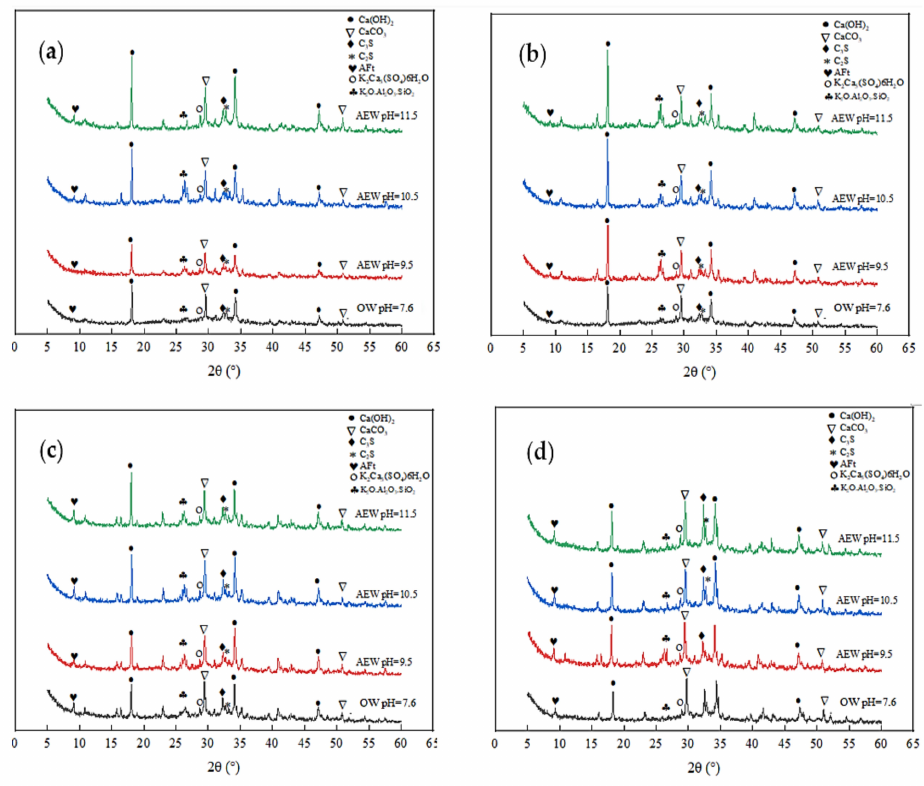
Figure 6. Diffraction pattern of XRD at 7 d: ( a ) FA = 0; ( b ) FA = 15%; ( c ) FA = 30%; ( d ) FA = 45%.